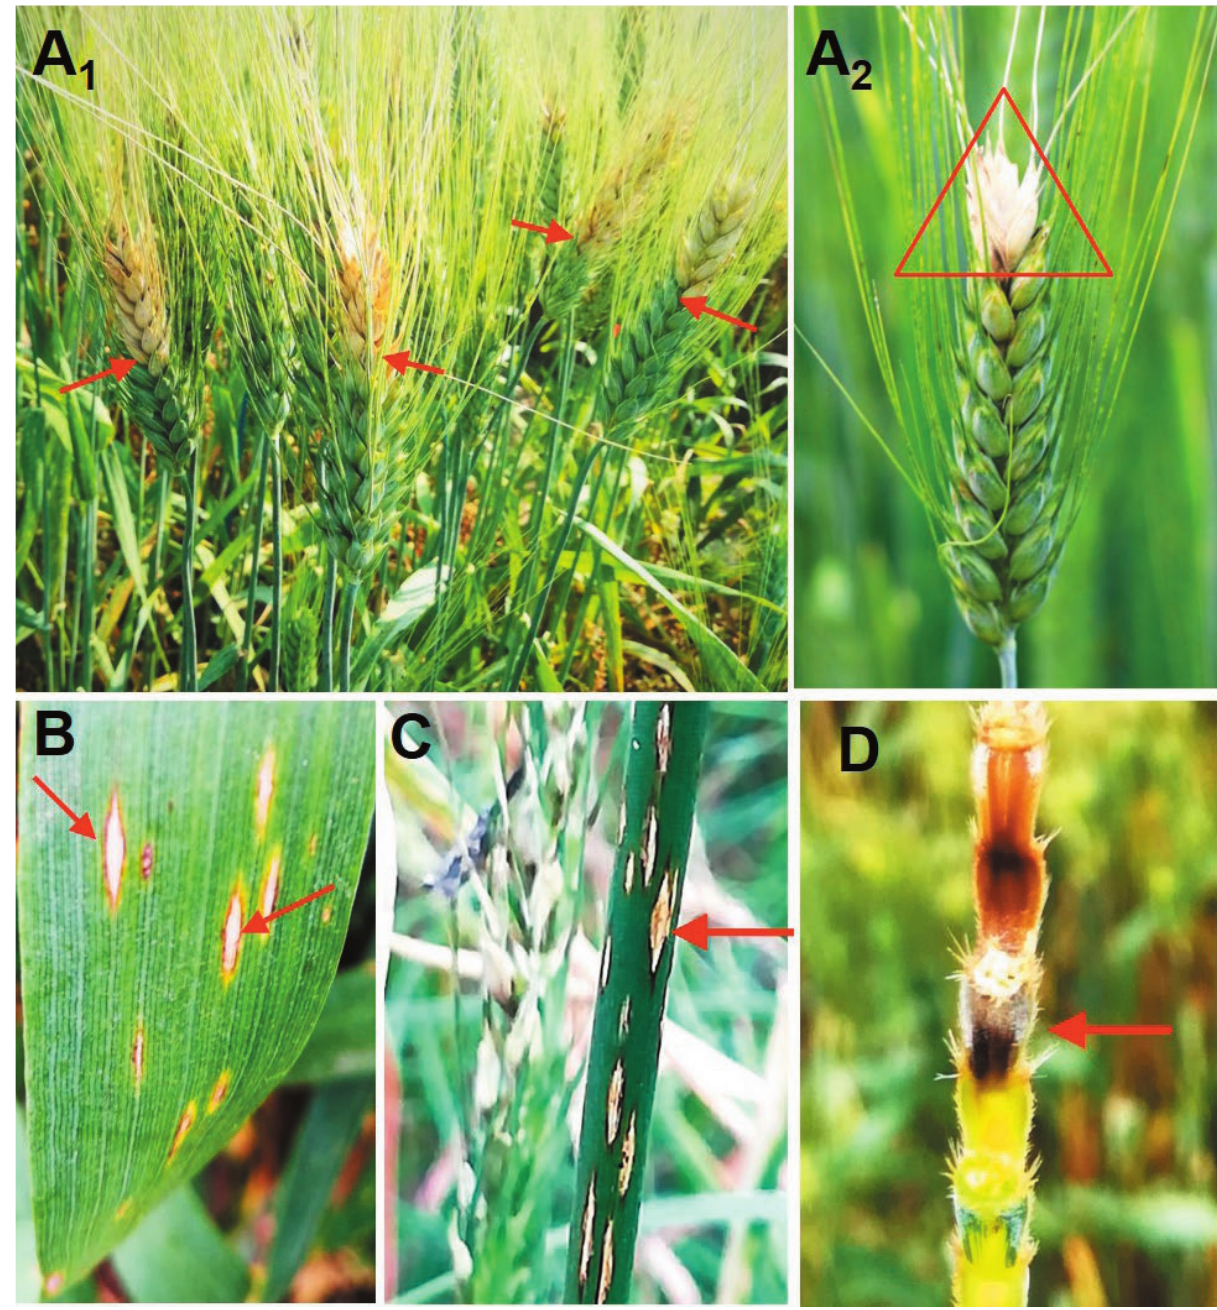
Figure 1. Field symptoms of durum wheat blast on different plant parts: (A 1 and A 2 ) typical partially-bleached spikes; (B) elongated or eye- shaped lesions on durum leaf with white centers surrounded by brown margins; (C) elongated lesion on stem with white center and dark brown or black margins; and (D) dark gray or brown infection points and gray to white sporulation in